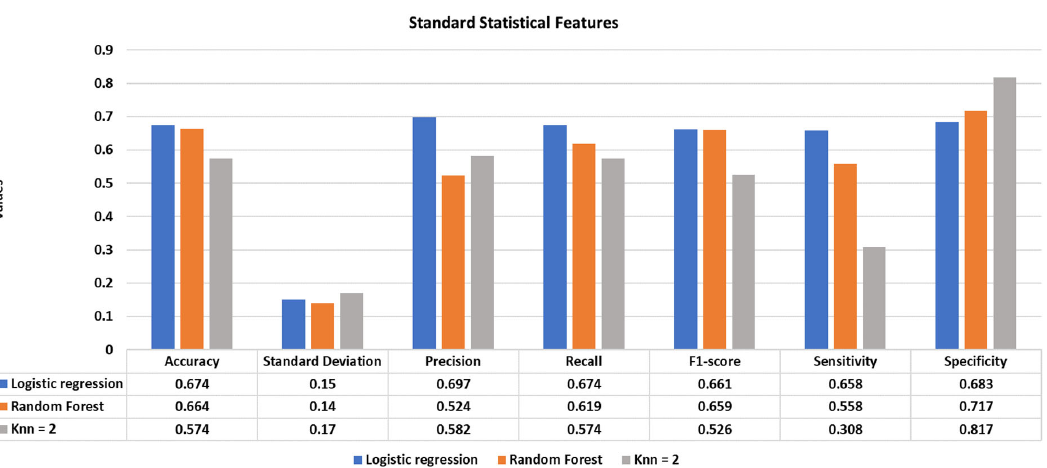
Figure 4. Standard statistical features-based stress versus baseline classification using logistic regression, random forest, and K-nearest neighbours classifiers.